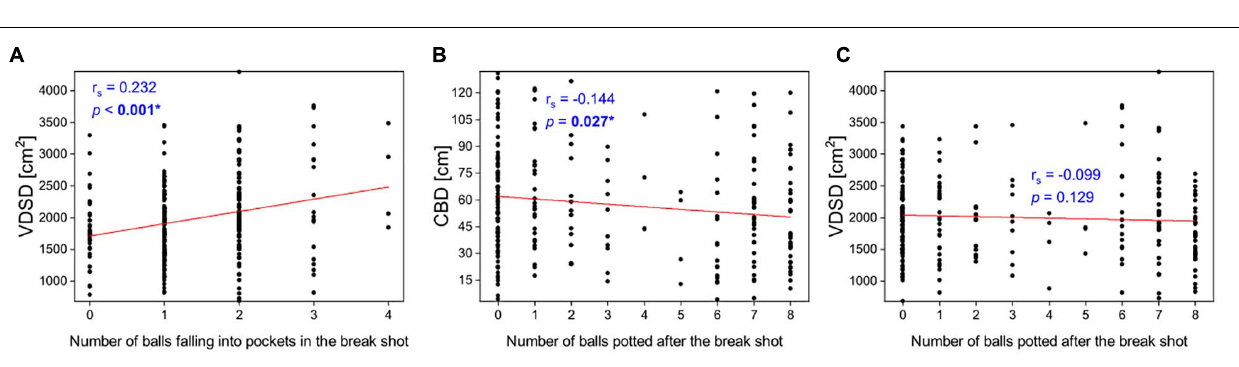
FIGURE 2 | Schematic representations of Voronoi diagram. (A) Dots (blue) are evenly distributed leading to a small standard deviation of cell areas. (B) Co-existence of both big and small cells causing a big standard deviation of cell areas.